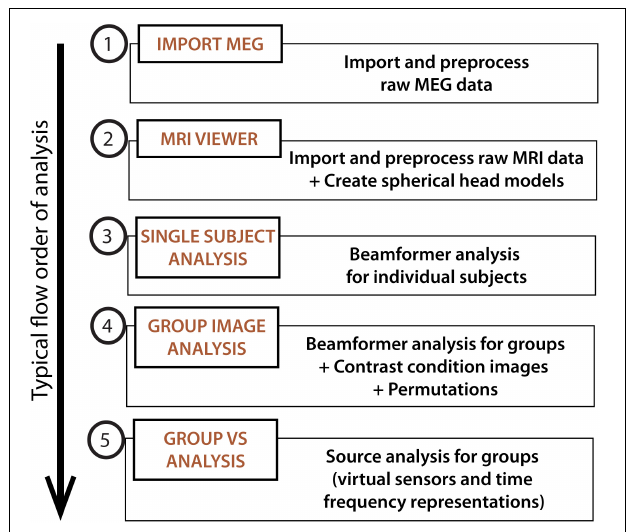
FIGURE 2 | BrainWave . The main menu can be used to launch the main analysis modules in BrainWave , including (1) the import and preprocessing of raw MEG data, (2) MRI preparation for MEG co-registration, (3) single subject beamformer analysis for exploratory and/or single patient data analysis, (4) group beamformer analysis, and (5) an additional module for time course plotting and time-frequency decomposition from arbitrary or pre-selected brain